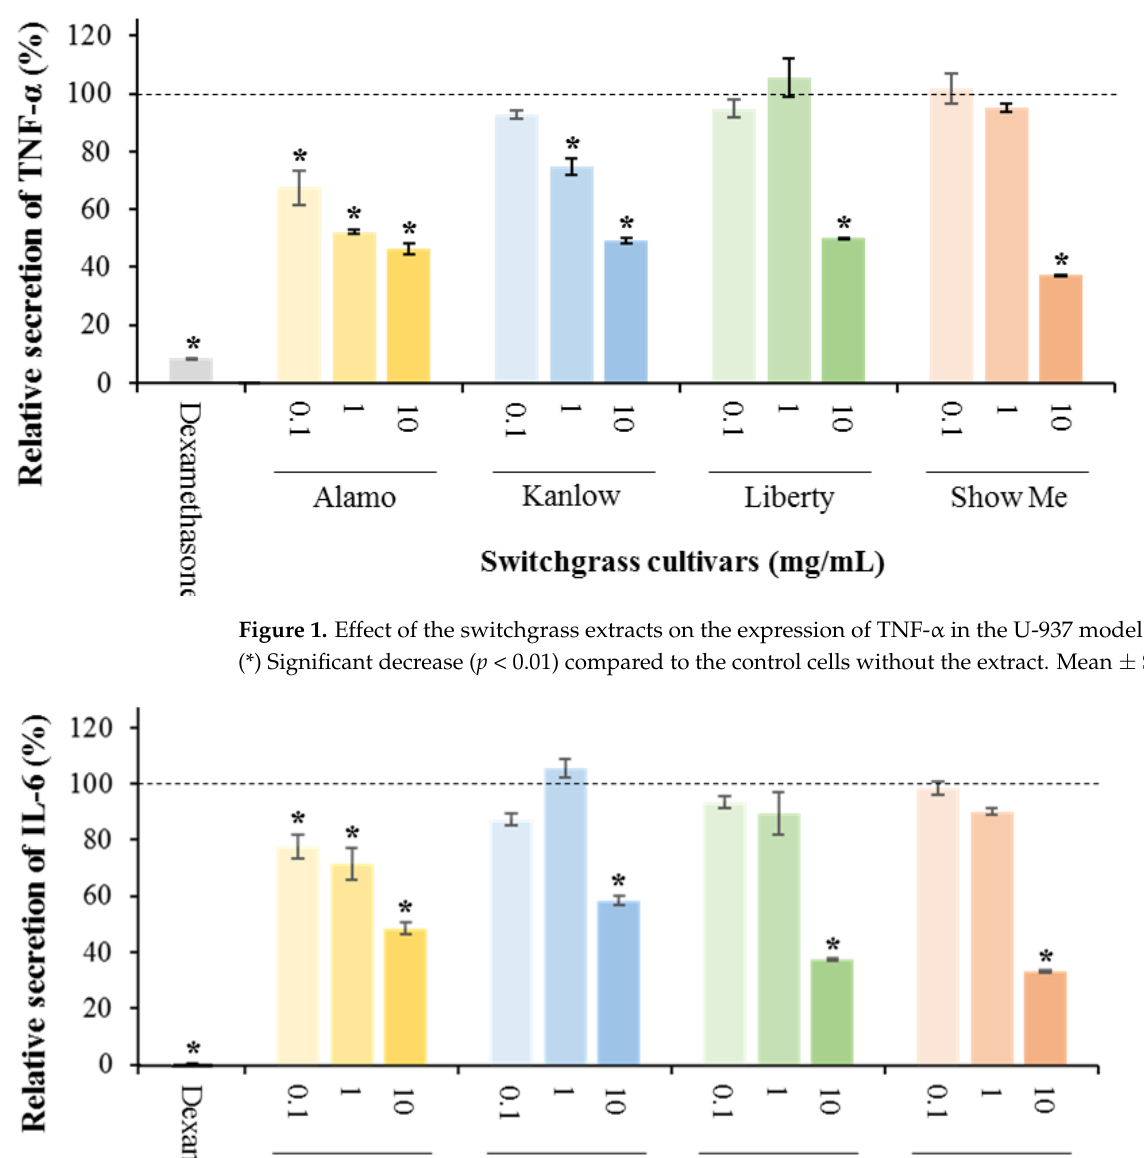
Figure 3. Effect of the switchgrass extracts on the expression of IL-8 in the U-937 model system. (*) Significant decrease ( p < 0.01) compared to the control cells without the extract. Mean ± SEM.